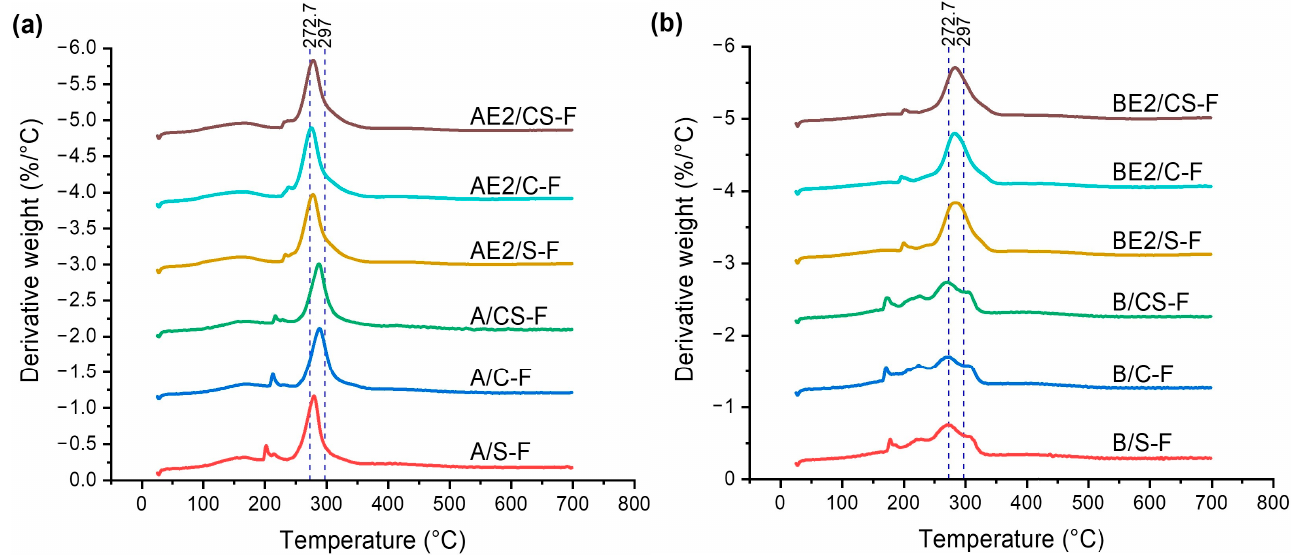
Figure 4. Derivative weight vs. temperature curves measured by thermogravimetric analysis (TGA) for the different bionanocomposite films: ( a ) chitosan matrix; and ( b ) chitosan/CMC matrix. The reference lines indicate the major peak temperatures of B ‐ F (272.7 °C) and A ‐ F (297 °C) [13].